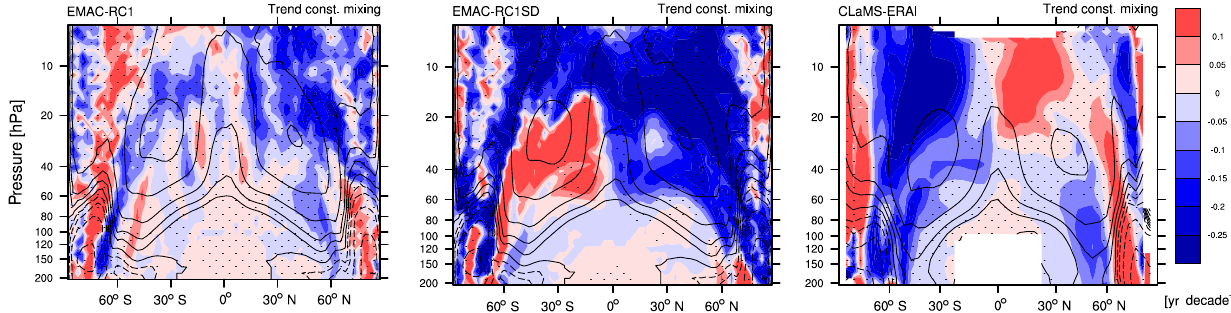
Figure 8. Trends (1990–2011) in resolved aging by mixing from residual circulation change alone for the simulation EMAC-RC1 (left), EMAC-RC1SD (middle) and CLaMS-ERAI (right). Black contours show climatological values. Stippling displays statistical significance on a 95% level. Units are given in yeardecade − 1